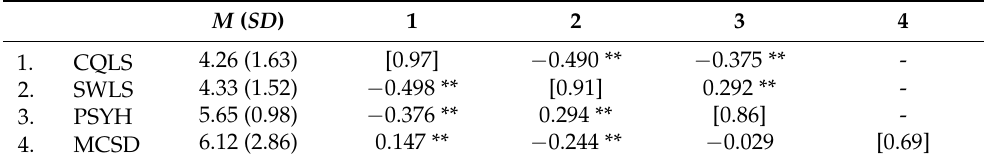
Table 2. Zero-order and Partial Correlates (controlling for social desirability) between Self- Reported